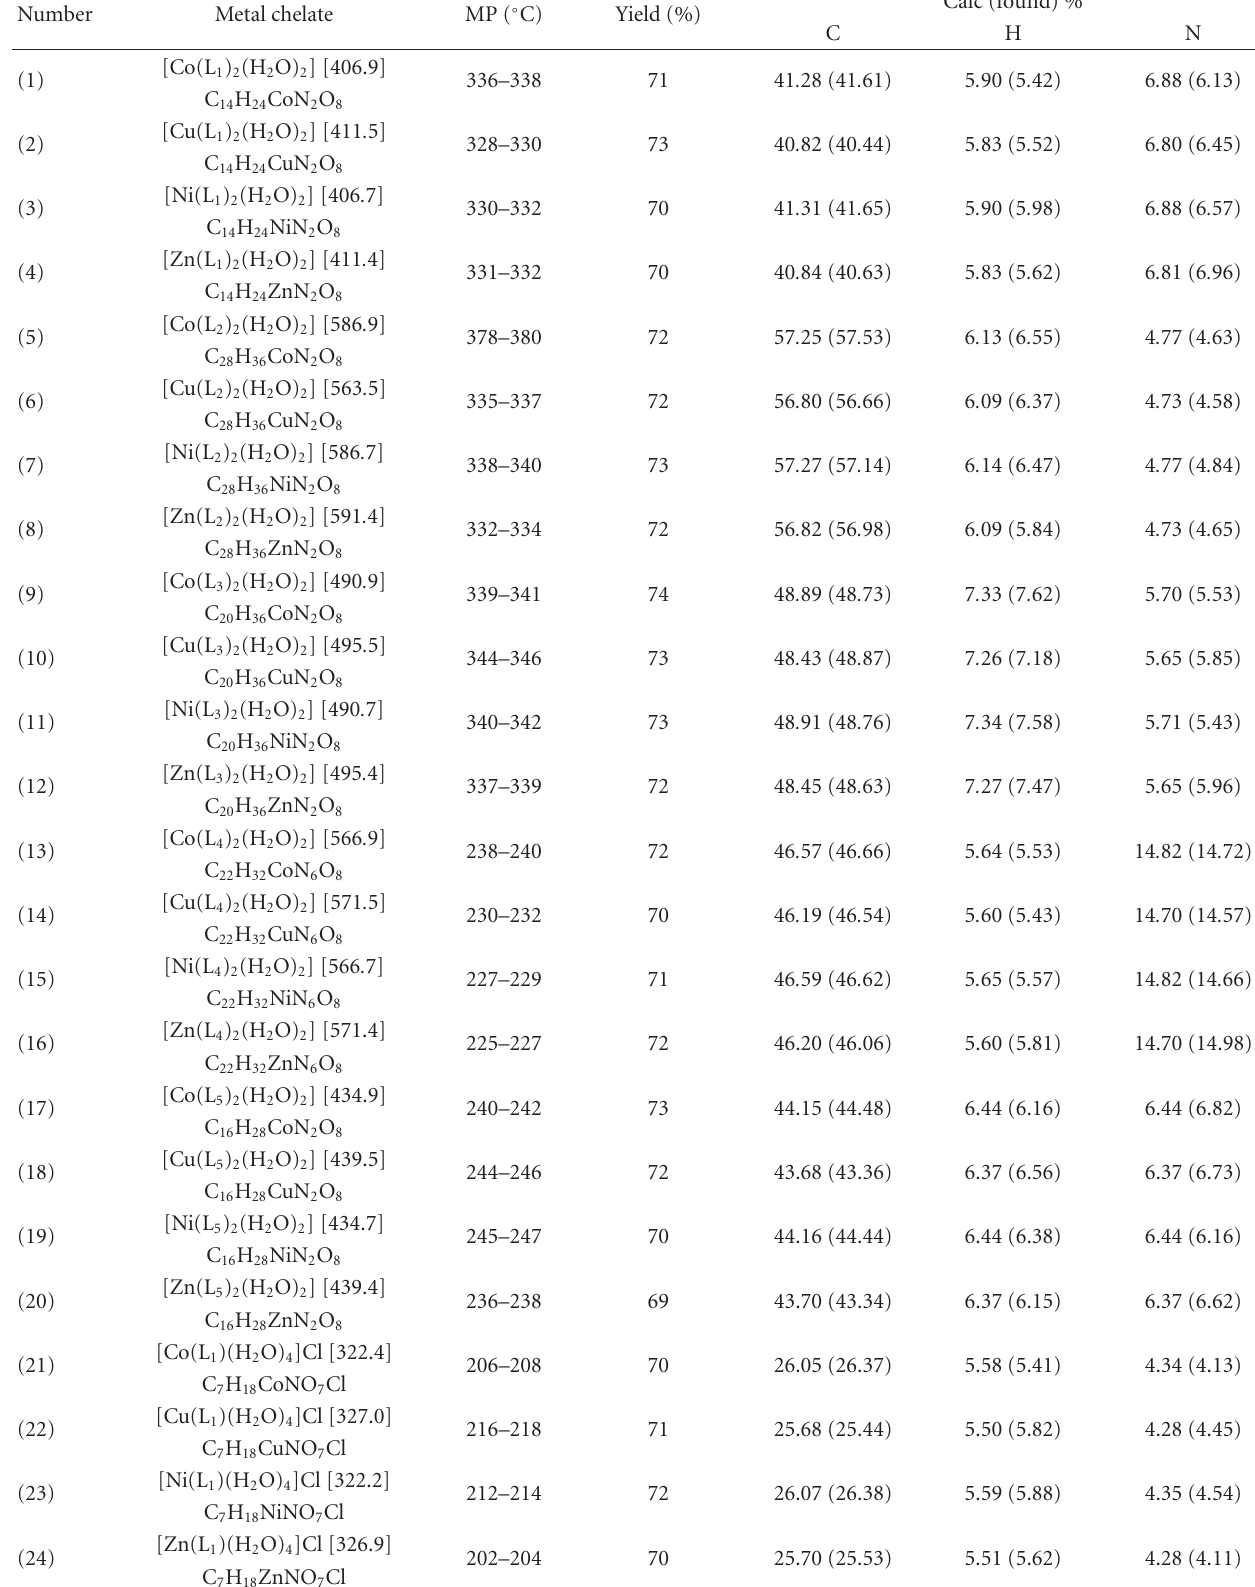
Table 1: Physical and analytical data of the metal(II) complexes